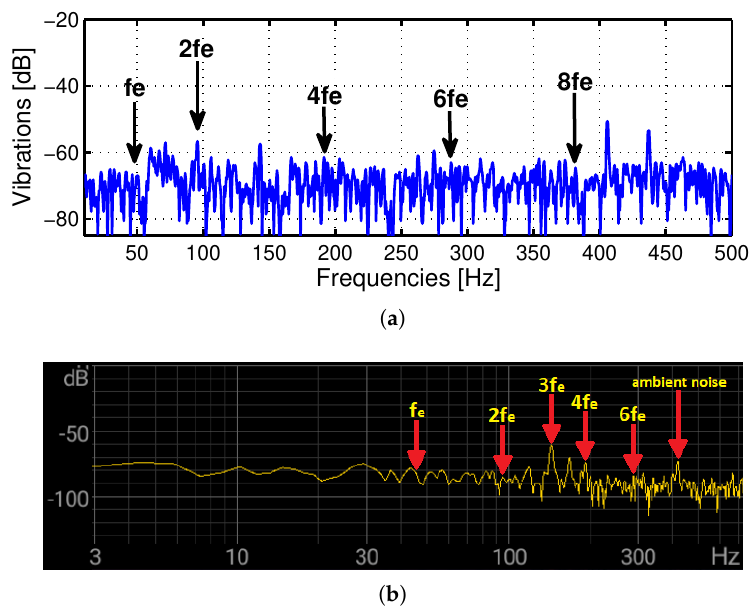
Figure 32. 2nd and 6th harmonic of cogging torque map applied, CHC ON, ω e = 300 rad FFT; ( b ) acoustic noise